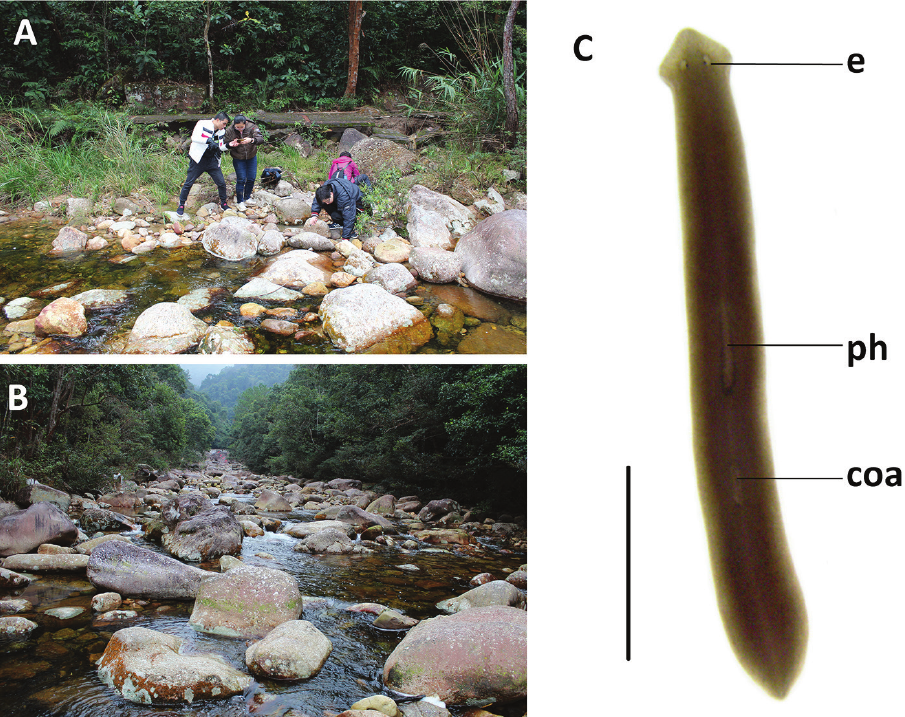
Figure 3. Habitat and external appearance of Dugesia circumcisa A sampling site B habitat C sexually mature, live individual. Abbreviations: coa: copulatory apparatus; e: eye; ph: pharynx. Scale bar: 5